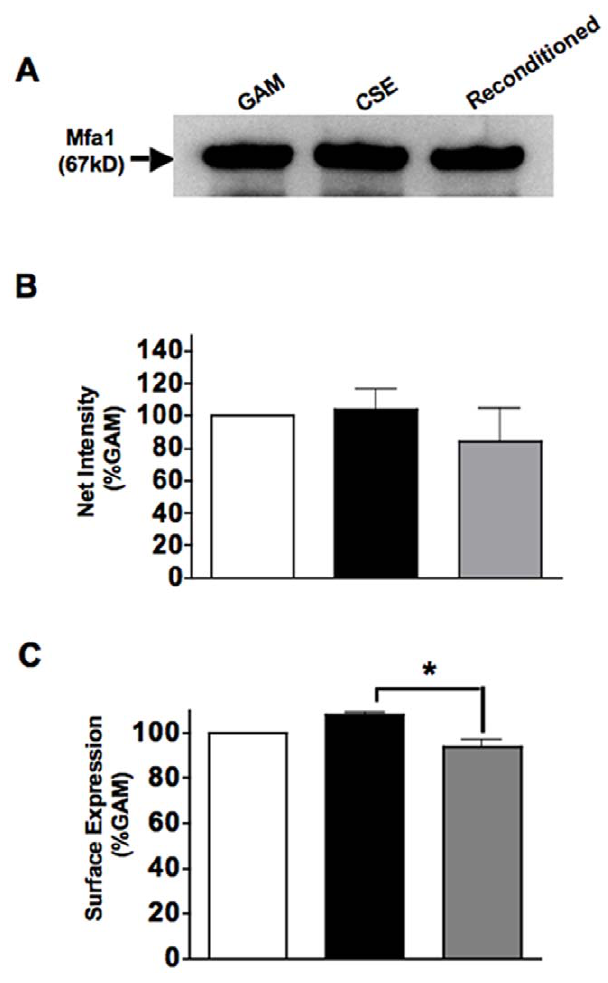
Figure 1. CSE exposure does not influence total protein levels or surface availability of Mfa1. (A) Western blots of 1 x 10 6 P. gingivalis cell lysates sequentially passaged in GAM, GAM-CSE, and then fresh GAM, respectively and re-probed with rabbit anti-Mfa1 antibody (blot was first probed for FimA, as shown in SupplementalFigure1 ). (B) Relative band intensities for Mfa1 expression (B) indicate Mfa1 protein levels remain unaltered by CSE exposure. Surface availability ELISAs for Mfa1 (C) confirm that Mfa1 availability on the P. gingivalis surface remains unchanged. * p , 0.05.